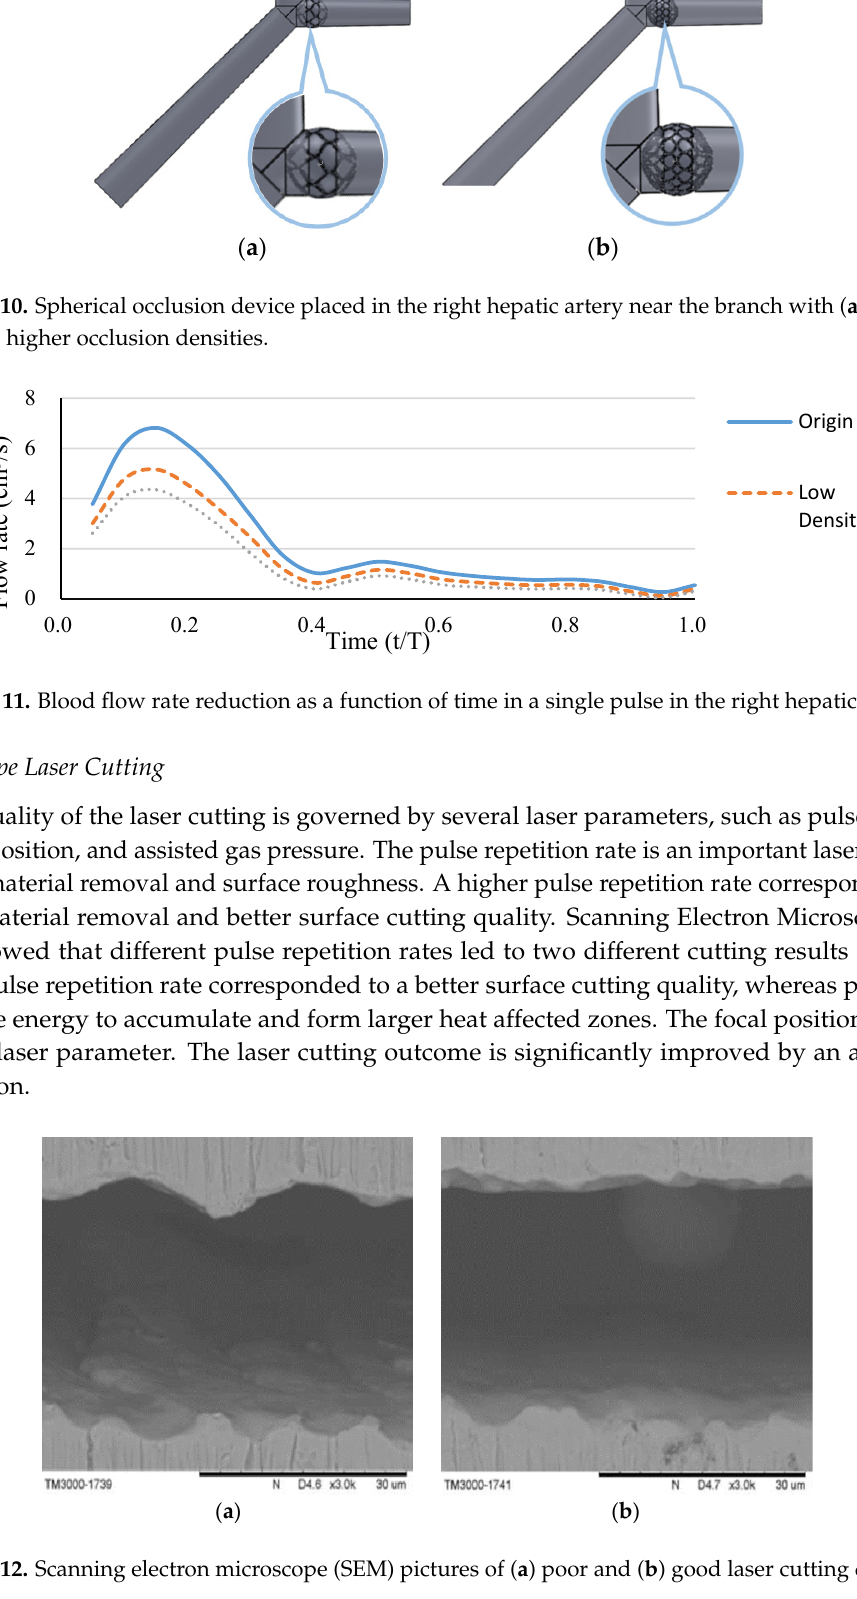
Table 1. Maximum strain occurring during the manufacturing and deployment procedures. Manufacturing/Deployment